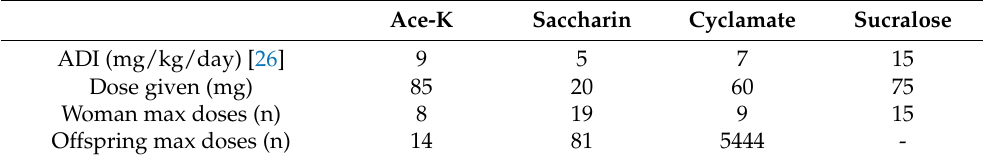
Figure 2. Grouped concentrations of ASs in breast milk. ( a ) represents grouped ace-k in breast milk, ( b ) represents grouped saccharin in breast milk and ( c ) represents grouped cyclamate in breast milk The dark grey represents group 1 (BMI < 25), the pink represents group 2 (BMI > 27), and the blue represents group 3 (T1DM). Outliers have been removed for each sweetener. Table 3. Acceptable daily intake (ADI) according to